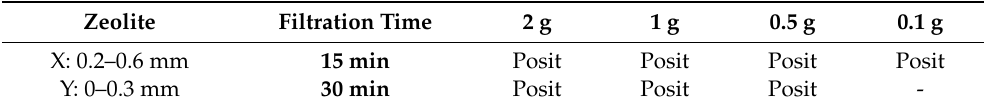
Table 1. C. parvum positive water samples after zeolite